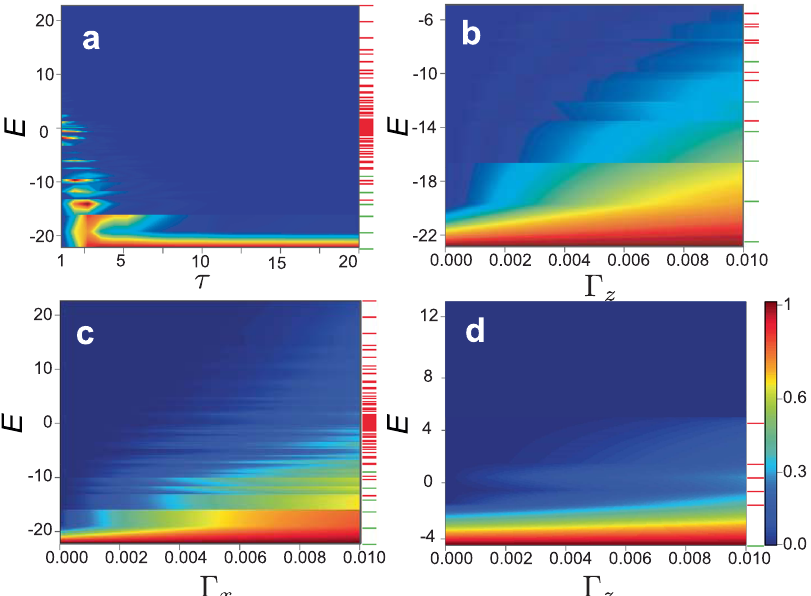
Fig. 3 Occupation probability of the fi nal state after time-evolving the adiabatic quantum computation. The occupation probability is plotted as a function of the ( a ) sweep time τ with N = 5 and Γ = 0; ( b ) S z decoherence rate Γ z with N = 5; ( c ) S x decoherence rate Γ x with N = 5; ( d ) S z decoherence rate Γ z with N = 1. The same parameters as Fig. 2b are used M = 3 J 12 = − 0.5, J 13 = 0, J 23 = − 1, K 1 = 0.5, K 2 = 0, K 3 = 1, and τ = 100. The probability distribution is normalized such that the maximal probability takes a value of 1 for each τ or Γ gure. For each plot, the spectrum of energy levels is labeled to the right of the plot. Green levels indicate logically equivalent states to the ground state, red levels indicate logical error